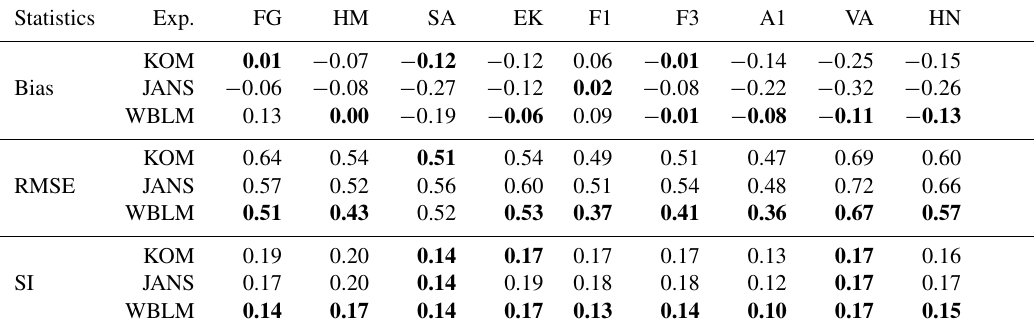
Table 6. Statistics of simulated significant wave height ( H m 0 ) in comparison to measurements at Fjaltring (FG), Hanstholm (HM), A121 (A1), Väderöarna (VA), Heligoland north (HN), Fino-1 (F1), Fino-3 (F3), Sleipner-A (SA), and Ekofisk (EK) on 28 November 2015 and 12 August 2015. The statistics include mean difference (bias), root mean square error (RMSE), and scatter index (SI). In each column, the values of smallest absolute errors are indicated with bold